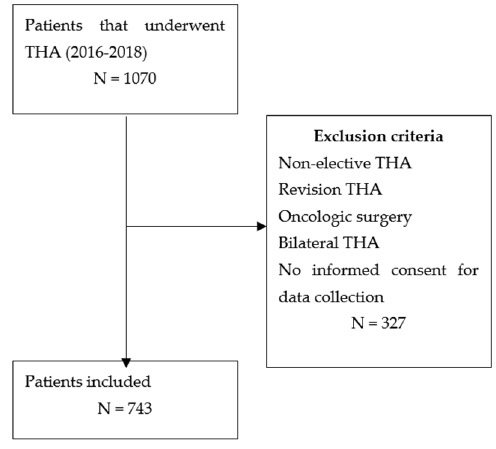
Figure 1. Medical records selection flow-diagram.